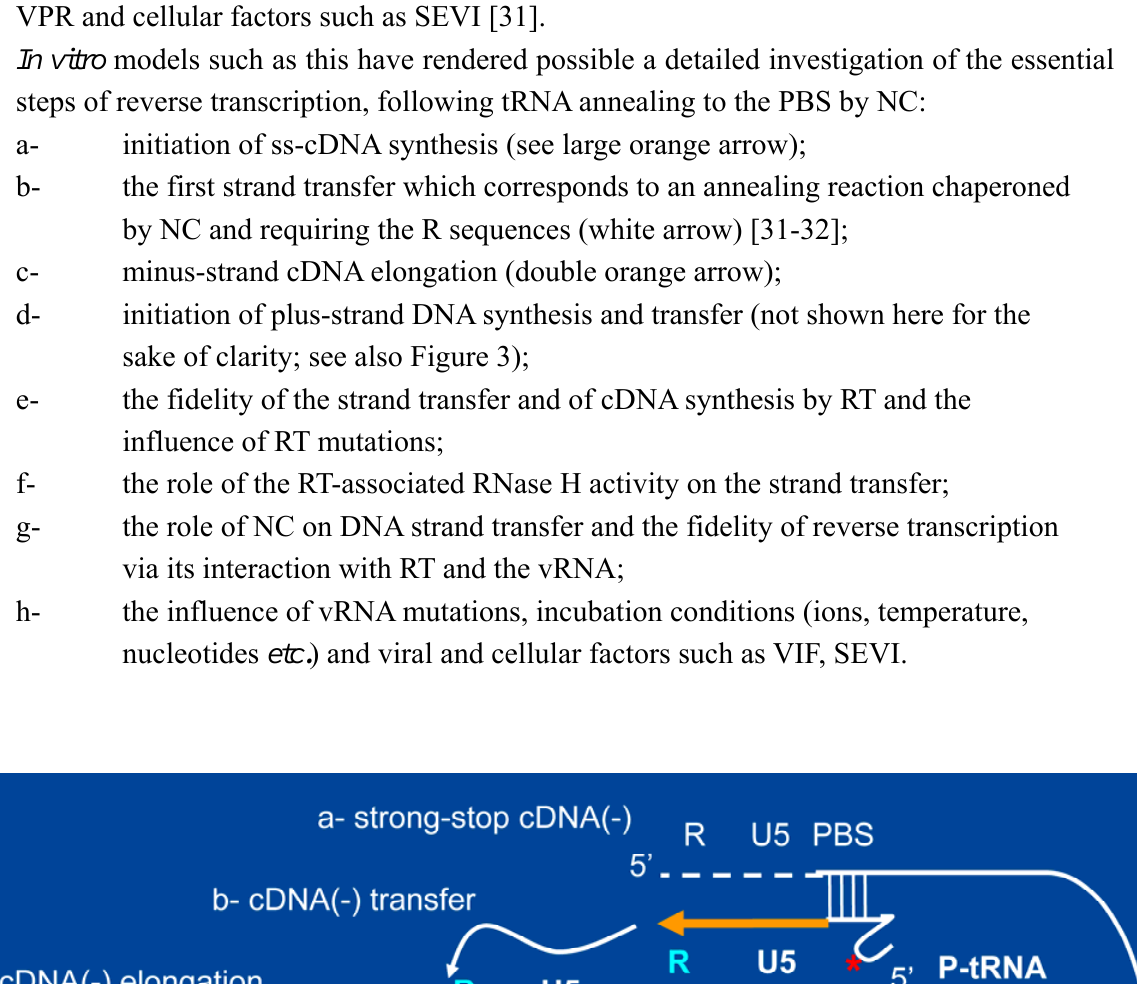
Figure 2 . In vitro model systems to study retroviral reverse transcription. Flexible in vitro model systems have been set up to study in detail the process of retrovirus reverse transcription [21,23-25,30]. Such models include (i) in vitro generated RNA (vRNA) representing the 5’ and 3’ UTR domains containing the cis -acting elements essential for cDNA synthesis, namely the PBS, the binding site for the replication primer tRNA, the untranslated 5’ and 3’ regions (U5 and U3), the repeats (R in blue) and the polypurine tract (PPT); (ii) Replication primer tRNA of natural origin (P-tRNA) or generated by in vitro transcription, or a synthetic oligonucleotide complementary to the PBS; (iii) the RT enzyme (not shown); (iv) NC protein (not shown); (v) if required, the IN enzyme, VIF, VPR and cellular factors such as SEVI